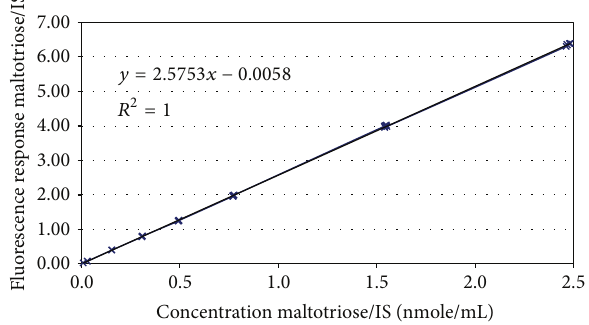
Figure 2: Calibration curve prepared using